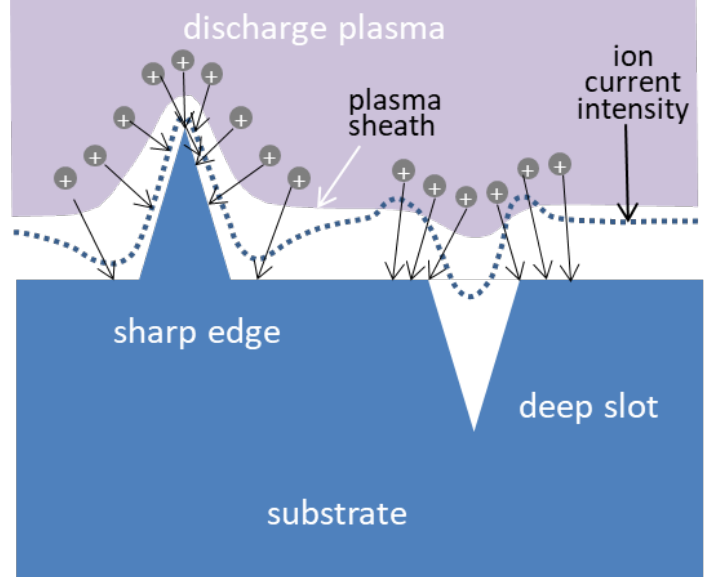
Figure 16. The sheath between homogeneous plasma and negatively biased substrate with complex geometric shape (sharp edges, slots) and the corresponding ion current density.